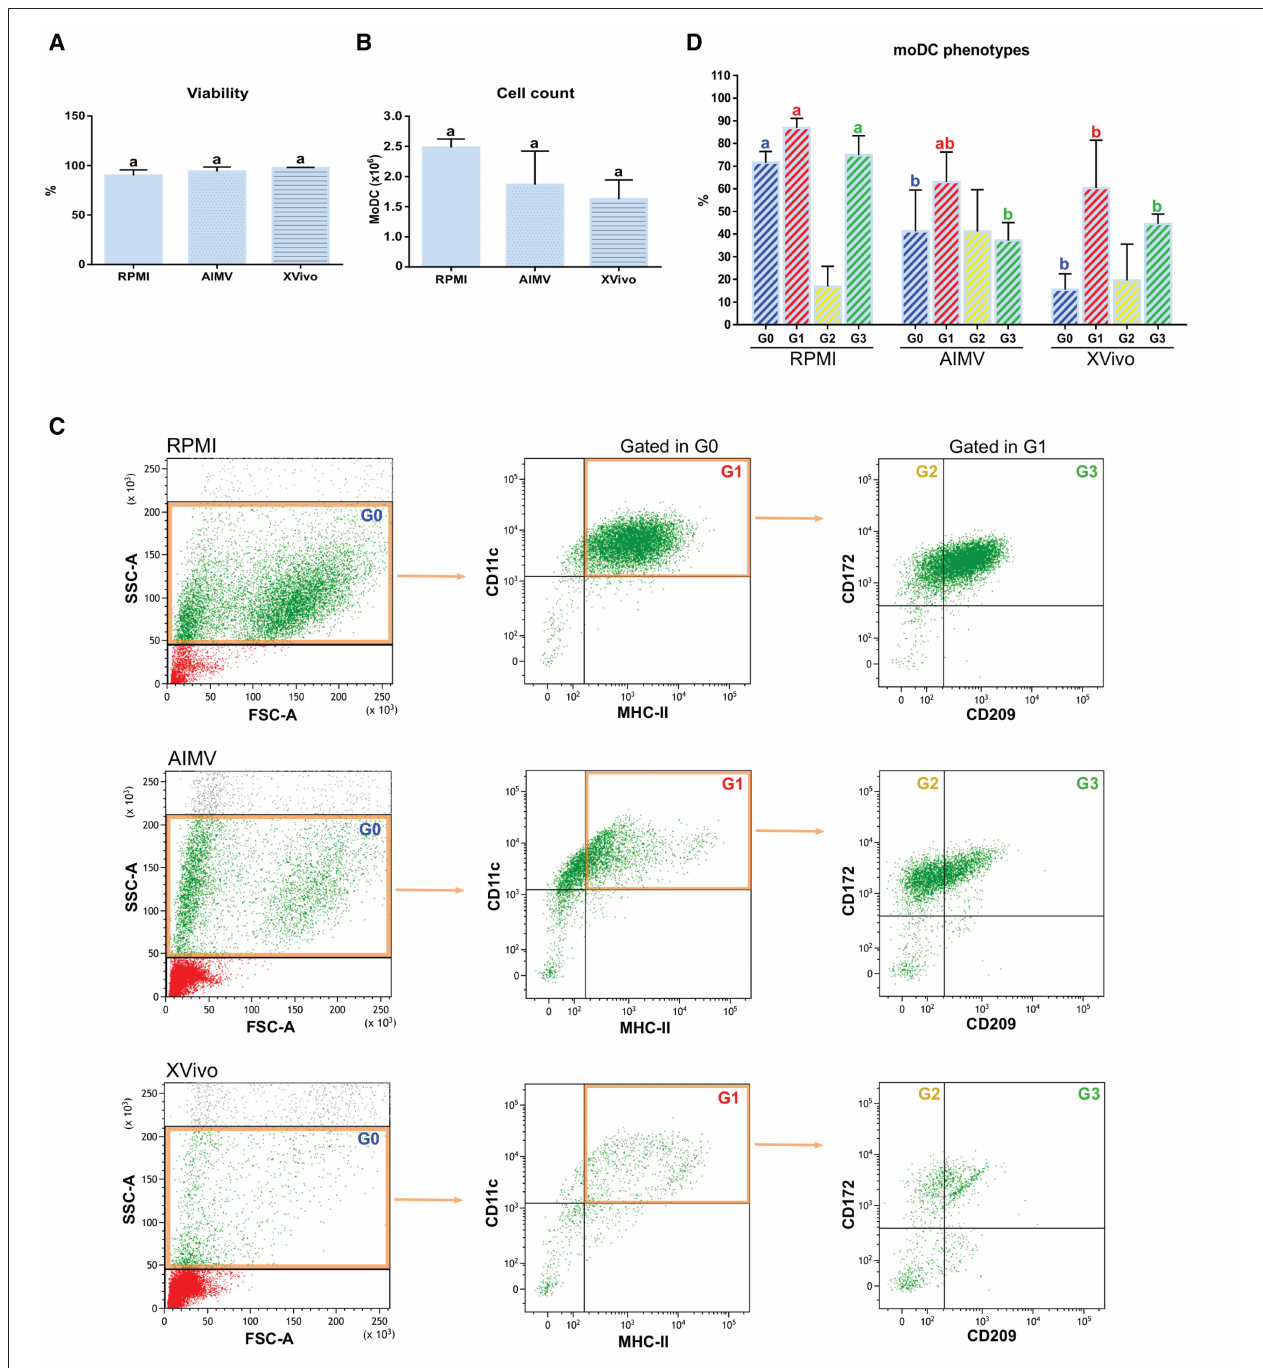
FIGURE 10 | Viability, yield, and phenotype of bovine moDCs produced in RPMI-FBS and serum-free media (AIM V and X-VIVO) at day 9. (A) Cell viability. (B) Total cell count. (C) Analysis of the surface markers such as MHC-II, CD11c, CD172, and CD209 by flow cytometry. The dot plots show the results of one representative experiment. Monolabeled and isotype controls are shown in Supplementary Figure 3D. (D) Bar plot depicts the percentage of cells in the gates indicated in (C) . Bars represent data from three independent samples (from different animals). Different letters represent mean statistically significant difference ( p < 0.05). Error bars represent